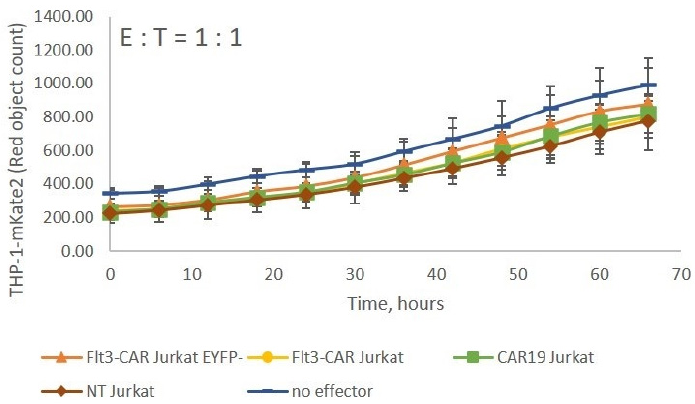
Figure 5. Flt3-CAR Jurkat cells lack cytotoxicity towards THP-1-mKate2 cells. Flt3-CAR Jurkat cells, Flt3-CAREYFP- Jurkat cells, CAR19 Jurkat cells, and non-transduced (NT) Jurkat cells were co-incubated with THP-1-mKate2 cells at E:T = 1:1. A color/shape legend for the lines and data points is given in the figure. ‘Red object counts’ acquired by IncuCyte ® reflect the viability of THP-1-mKate2 cells. The data are represented as means ± SD.